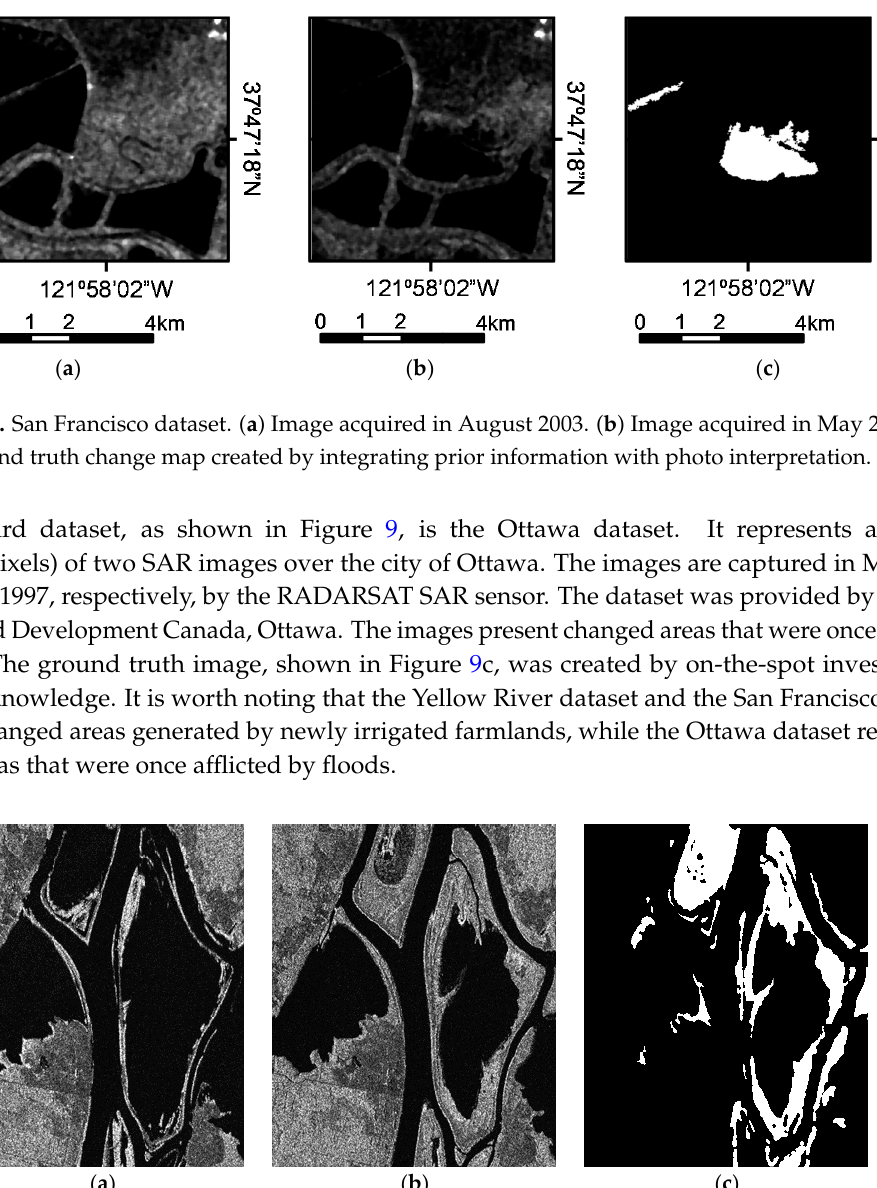
Figure 7. SAR images acquired by ERS-2 over the city of San Francisco.